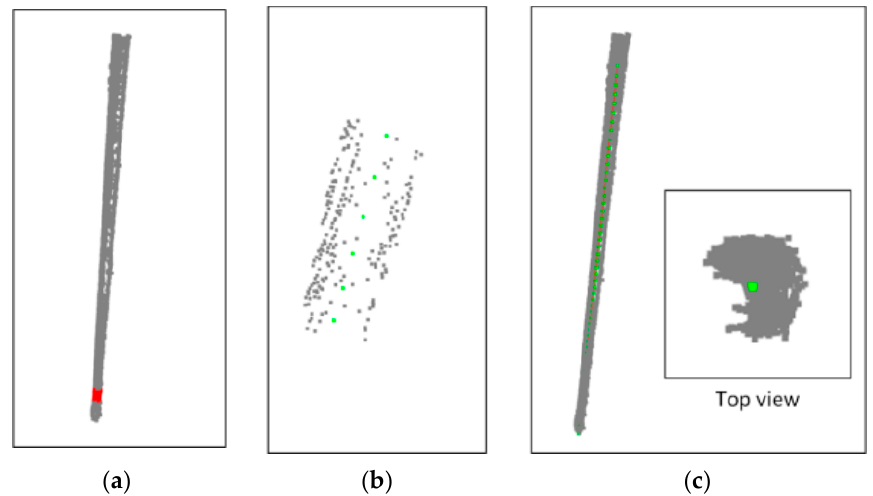
Figure 13. The fitting result of the central axis of the pole. ( a ) Point cloud intercepted; ( b ) RANSAC fitting cylinder; ( c ) Central axis fitted.